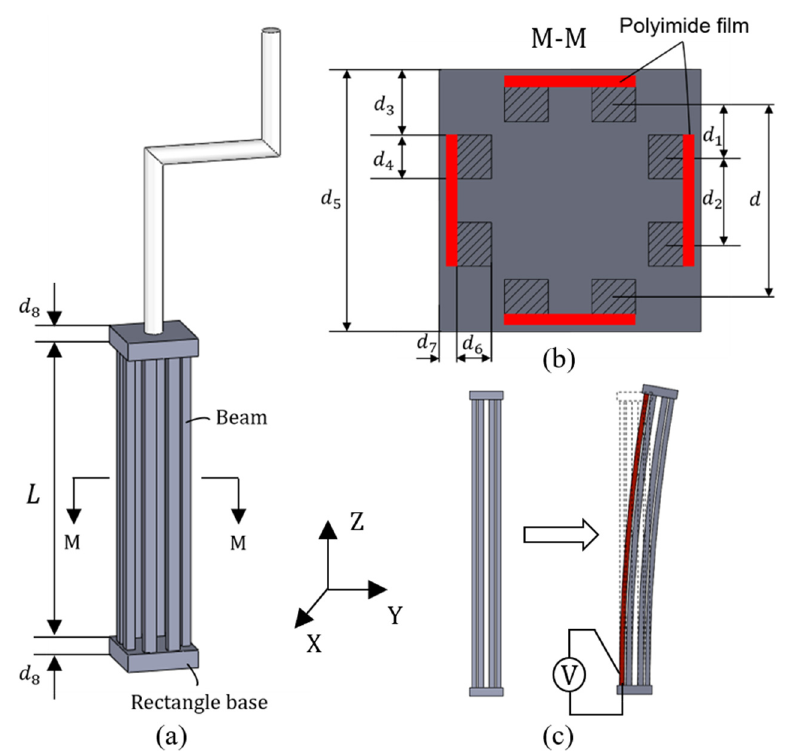
Figure 3. Detailed structure design of 3D U-shaped electrothermal actuator. ( a ) structure of 3D U-shaped electrothermal actuator; ( b ) the sectional view of 3D U-shaped electrothermal actuator; ( c ) deformation of the 3D U-shaped electrothermal actuator. Table 2. Dimensions of the 3D U-shaped electrothermal actuator (unit of length: mm).